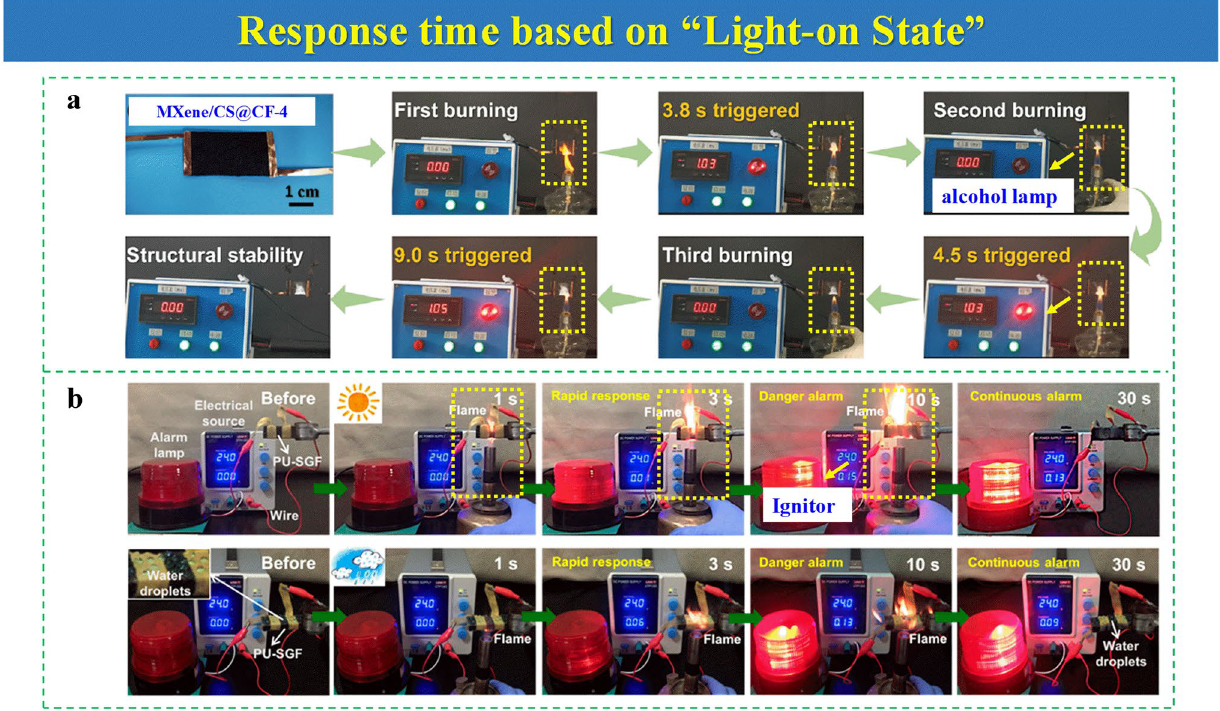
Fig. 3 a Video snapshots of the fire‑warning test process of MXene/CS@CF‑4 burned by an alcohol lamp. Reproduced with permission from Ref. [39]. Copyright 2021 American Chemistry Society. b Picture from the whole flame detection processes for multilayered PU (PU‑SGF) warning sample burned by an ignitor under different environmental conditions. Reproduced with permission from Ref. [64]. Copyright 2018 American Chemistry